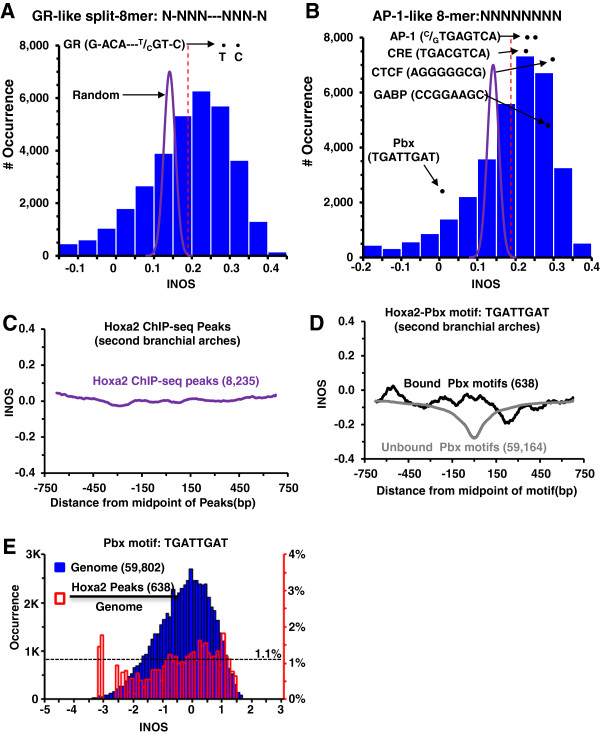
The GR and AP-1 motifs are calculated to be well-bound by nucleosomes. (A) Distribution of the INOS for 32,896 GR-like 8-mers (N-NNN---NNN-N). The INOS for each split 8-mer is calculated from 1,000 simulated 150-bp DNA sequences with the GR-like 8-mer in the center. The GR motifs are calculated to bind nucleosome better than the average GR-like 8-mer. The two GR motifs (G-ACA---T/CGT-C) are highlighted. Average INOS for all split 8-mers is shown as a dashed vertical red line. Distribution of INOS (0.141±0.015) for 32,896 random control set following Gaussian distribution is shown in purple. (B) Distribution of the INOS for all continuous 8-mers (NNNNNNNN). (C) Average INOS for 8,235 Hoxa2 ChIP-seq peaks [23]. (D) Average INOS near (±750-bps) canonical Pbx motifs (TGATTGAT); 638 bound as observed in the Hoxa2 ChIP-seq peaks and 59,164 unbound Pbx motifs are shown. (E) The blue histogram shows the distribution of INOS for all 59,802 Pbx motifs and the red histogram shows the percent bound by Hoxa2.